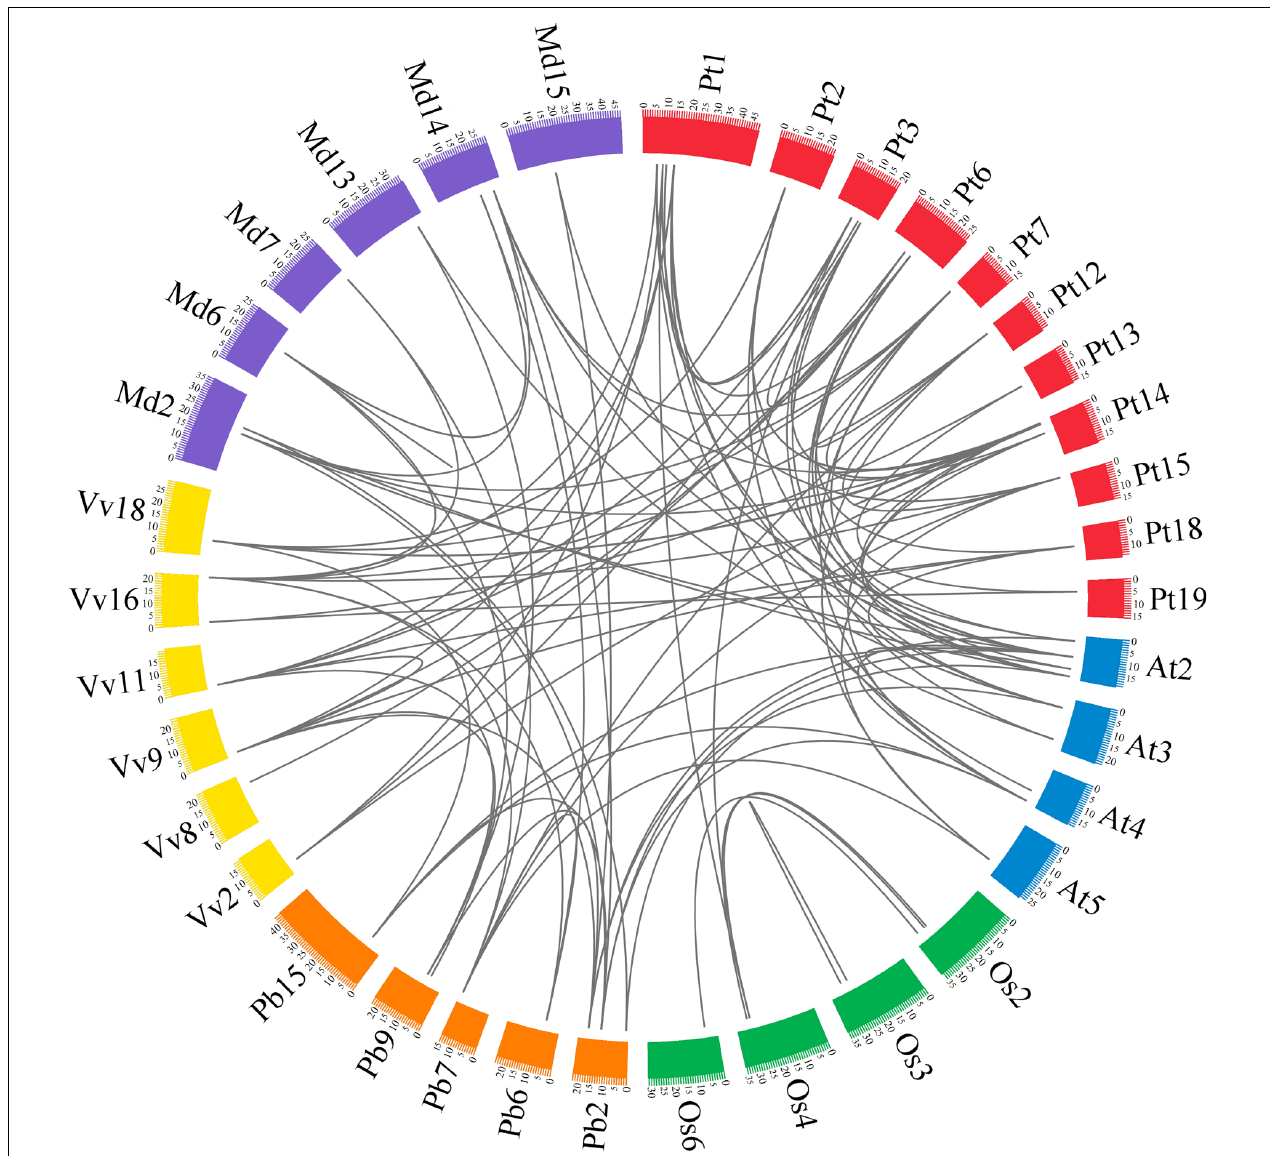
FIGURE 5 | Extensive microsynteny of GRF regions across six plant species. The pear, apple, Populus , grape, Arabidopsis and rice chromosomes are depicted as different color boxes and labeled Pb, Md, Pt, Vv, At and Os, respectively. The scale on the circle is in megabases. Syntenic relationships between GRF regions are represented by black lines. The apple GRF gene family was obtained from The Apple Gene Function and Gene Family Database (Zhang et al.,